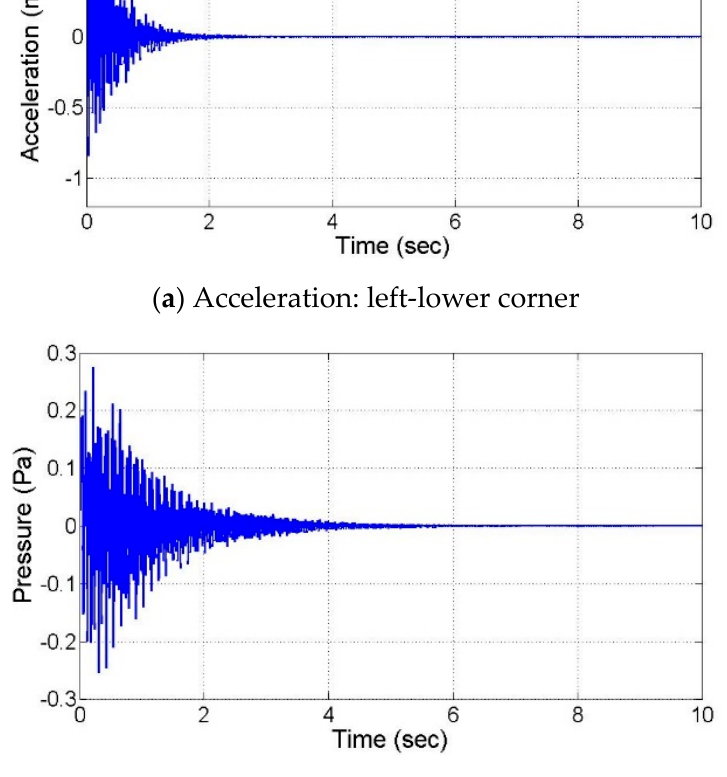
Figure 4. The time − history characteristics of vibration and impact sound generated by vibration; ( a ) time history of vibration after shocking ( b ) time history of impact sound generated by vibration.